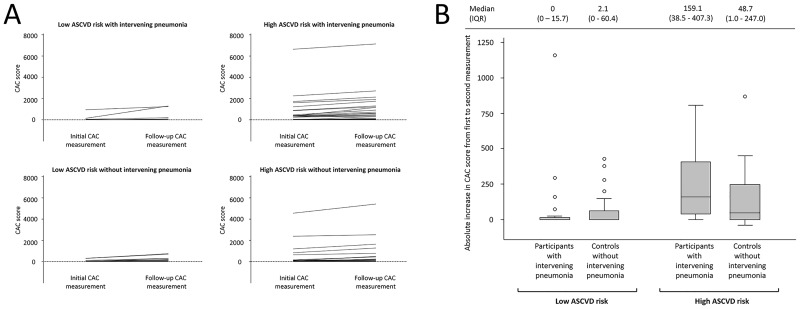
Trajectories of change (panel A) and absolute magnitude of change (panel B) of CAC scores in participants with and without intervening hospitalization with pneumonia stratified by their baseline risk of arteriosclerotic cardiovascular disease (ASCVD).